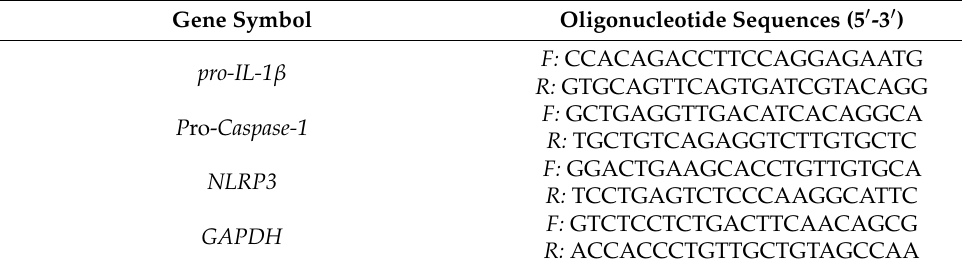
Table 1. Primers used for quantitative real-time